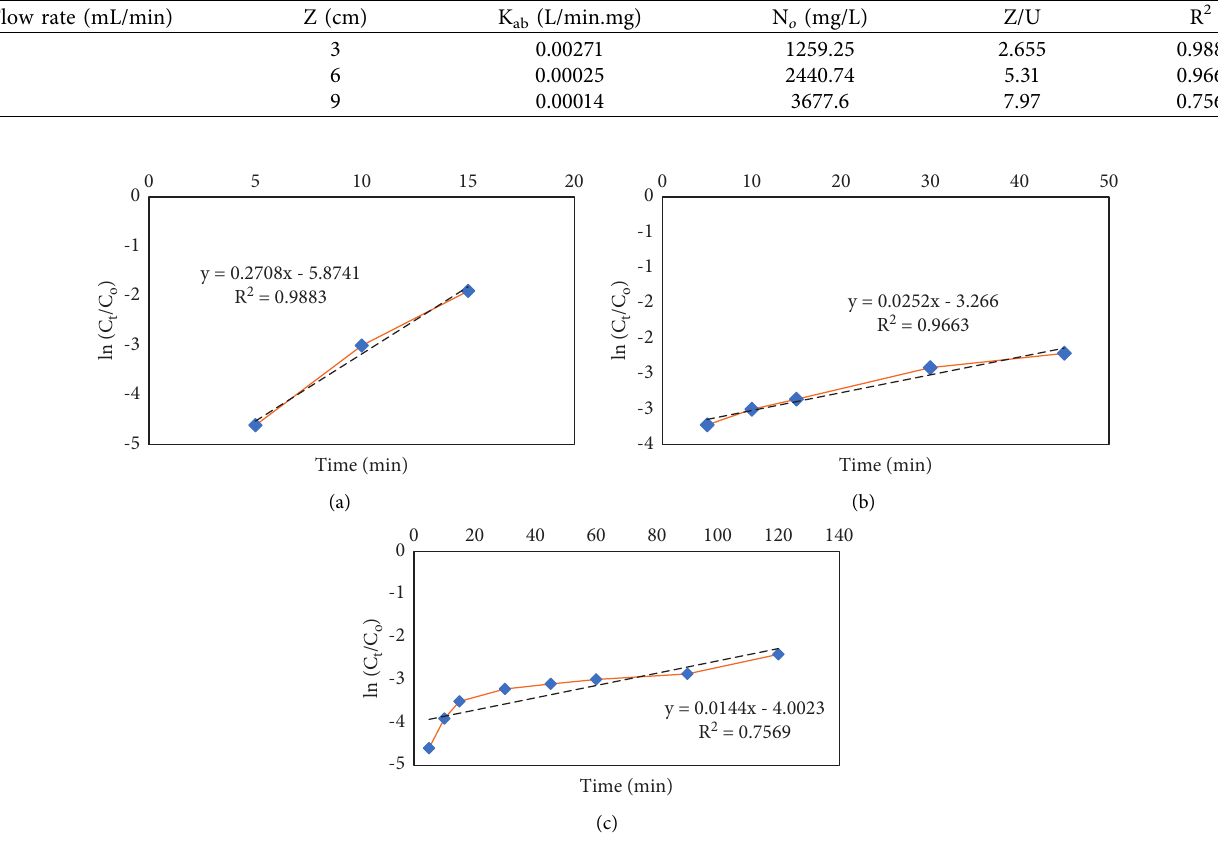
Table 4: Kinetics of the Adams–Bohart model for copper removal.